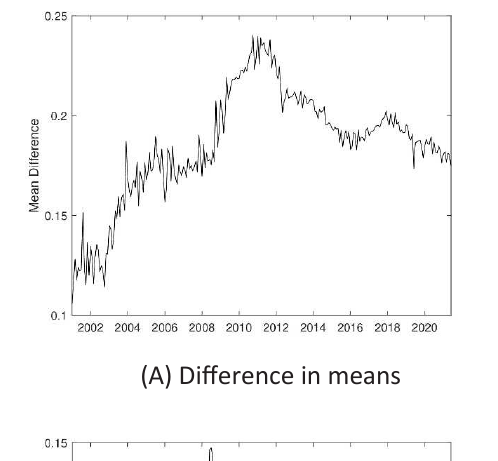
(A) Difference in means (B) Difference in standard deviation